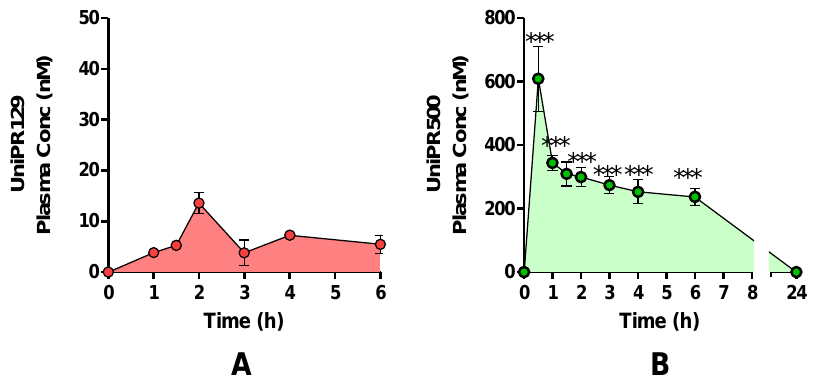
Figure 9. Plasma concentrations after a single UniPR p.o. dose of 30 mg/kg to mice. (mean ± S.E.M.; n = 4). ( A ) UniPR129. ( B ) UniPR500. Statistical significance set at ***: p < 0.001 by two-tailed Student’s